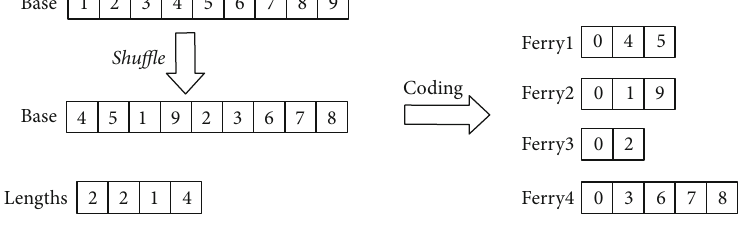
Figure 3: Chromosome coding process.